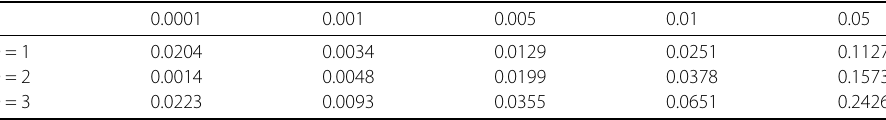
Table 4 k = 1.2, the relative root mean square errors (cid:10) ( v ) for various noise levels